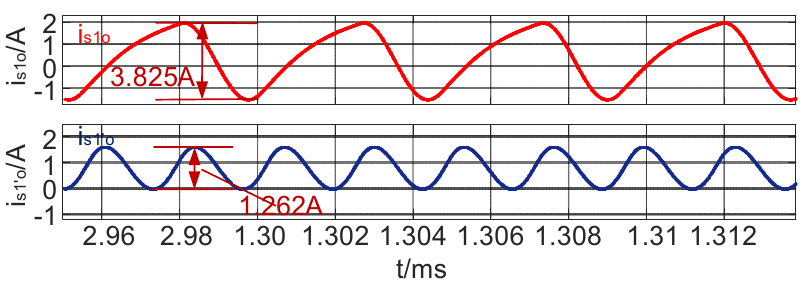
Figure 18. Traditional topological on-load 180° phase-shifting input current waveform . Figure 19. IDC on-load 180° phase-shifting input current waveform. Figure 19. IDC on-load 180 ◦ phase-shifting input current Figure 19. IDC on-load 180° phase-shifting input current waveform.